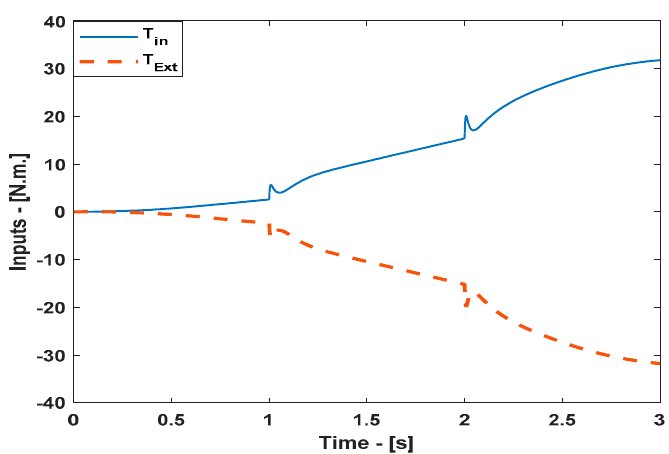
Figure 7. The input signals for the LQR scheme while altering the clutches’ status at different time intervals while the system is running.